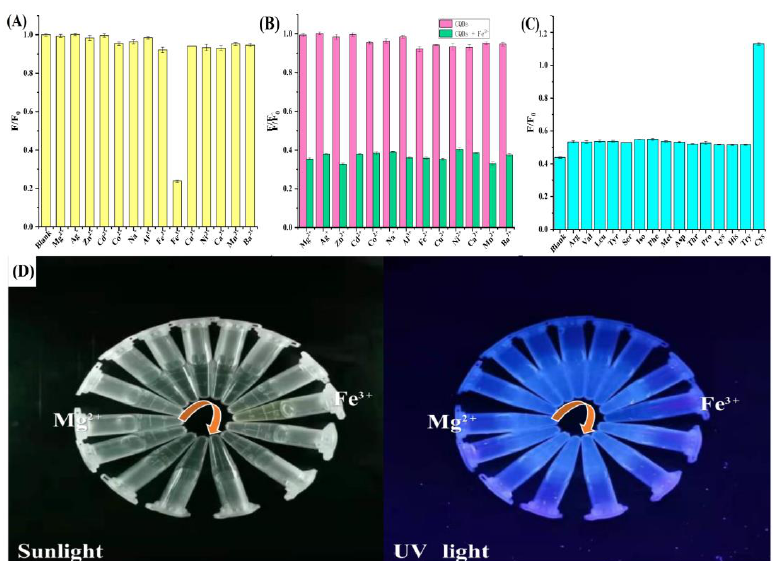
Figure 2. ( A ) Influences of metal ions (1 mM) on fluorescence intensity of CQDs. ( B ) Influences of metal ions (1 mM) on fluorescence intensity of CQDs/Fe 3+ system. ( C ) Influences of amino acids (1 mM) on fluorescence intensity of CQDs/Fe 3+ /L-Cys system. ( D ) Selectivity experiments under sunlight and UV light (365 nm, red arrow is consistent with the abscissa of Figure 2A).